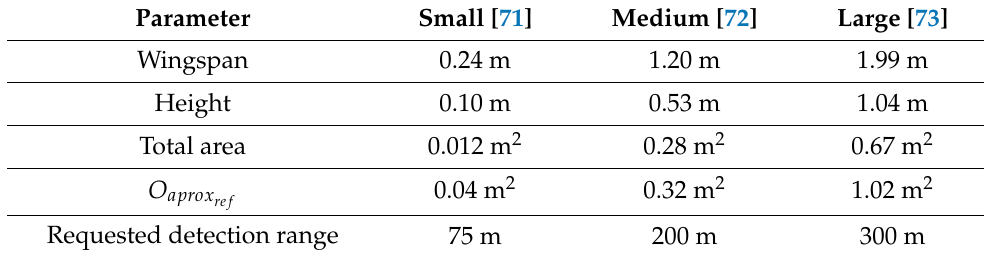
Table 3. Parameters of drones used for the